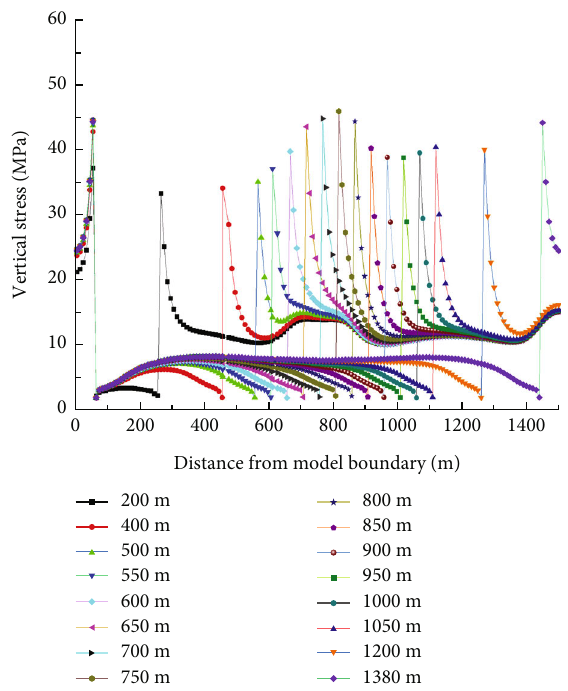
Figure 7: Abutment pressure in the center of 42107 working face.